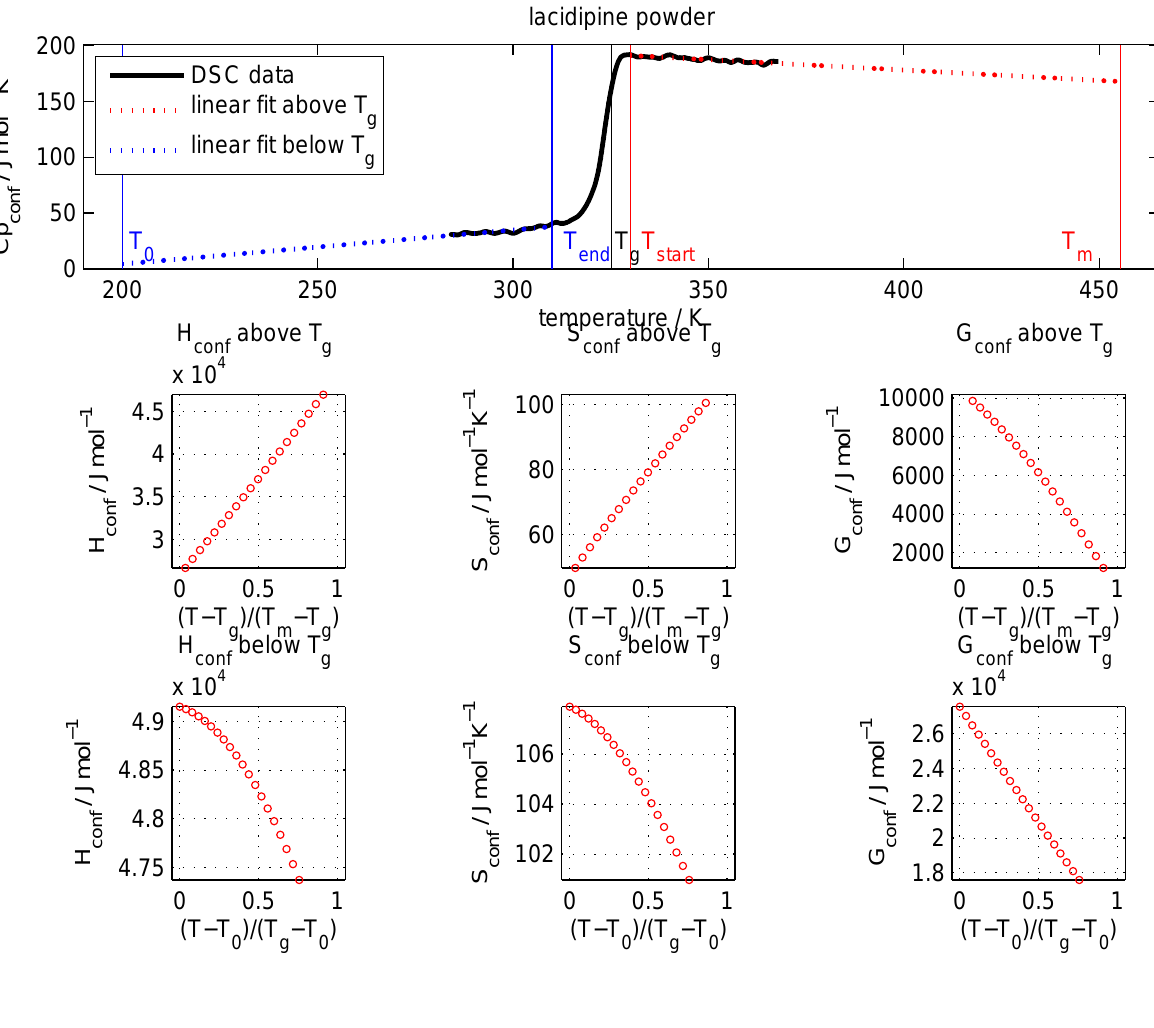
Figure 8. Output figure of the Matlab script showing the experimental DSC trace, the data provided by the user for T (top row) together with the H T (bottom g